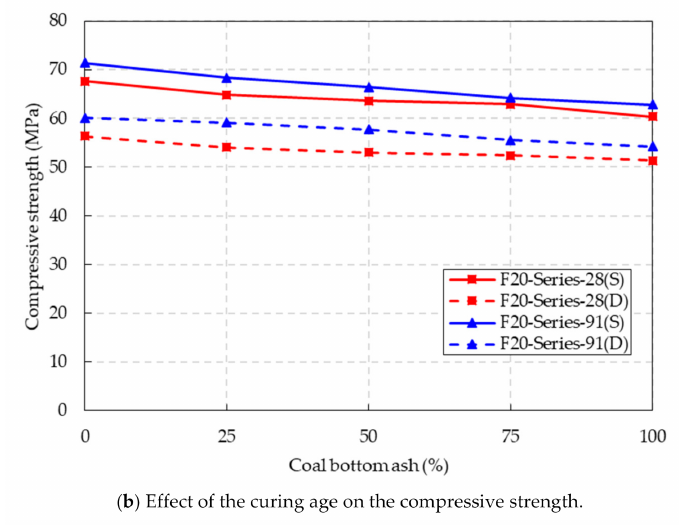
Figure 7. Compressive strength test results. The elastic modulus of the concrete mixture is provided in Table 4. The elastic modulus of the CBA concrete was also affected by the drying conditions and curing ages, as shown in Figure 8. The elastic moduli of the F20 and F40 series mixtures under oven-dried conditions were slightly lower than those under SSD conditions. The elastic moduli of the F20 series mixtures at a curing age of 91 days were slightly greater than those at a curing age of 28 days. The test results indicated that the elastic modulus of the CBA concrete increased with curing age.